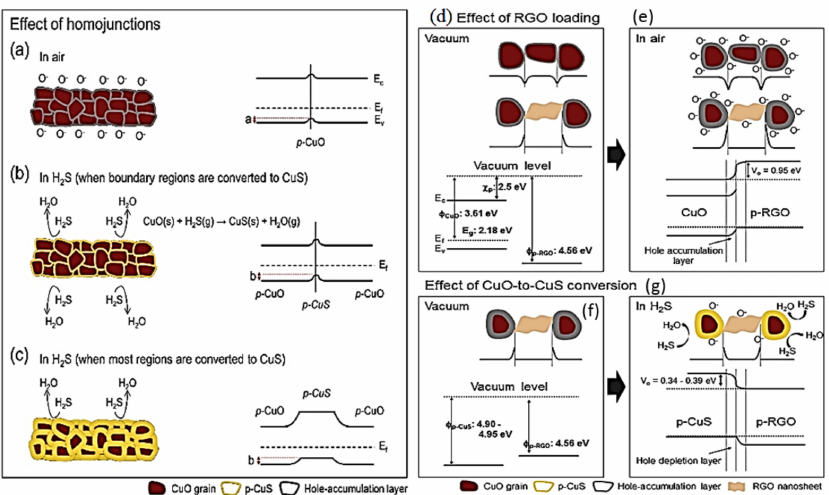
Figure 5. Effect of ( a ) oxygen adsorption and ( b , c ) conversion of CuO to CuS on the CuO/CuS band structure; ( d ) energy band structure CuO–rGO before contact in vacuum; ( e ) formation of potential barriers upon the contact of rGO-CuO in air; ( f ) energy band structure CuS–rGO before contact in vacuum; ( g ) formation of potential barriers upon the contact of rGO-CuS in H 2 S gas. Reprinted from [64] with permission from